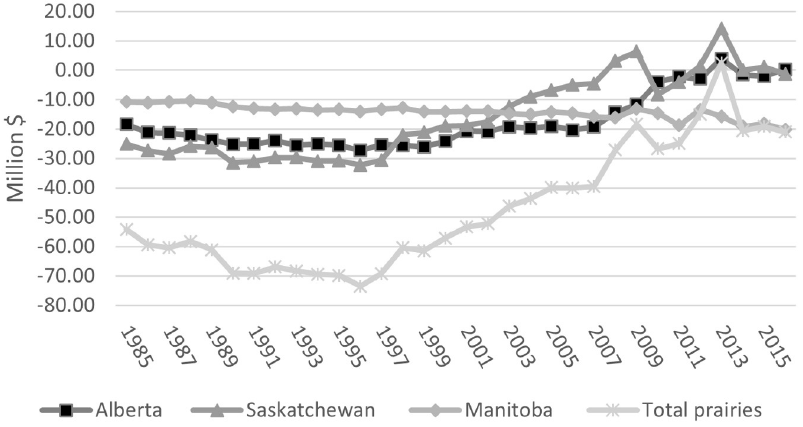
Fig 7. Net GHG value in the Canadian Prairies crop sector, 1985–2016 (price of CO 2 eq/ton = C$10, $2018).